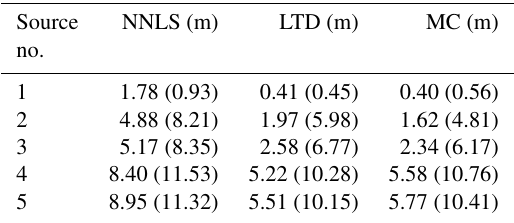
Table 2. Mean and standard deviation of the peak location